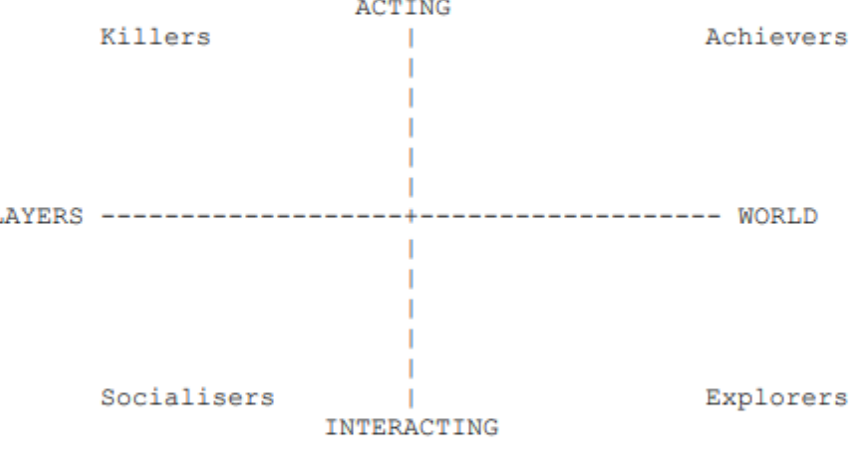
Figure 1. Four player types of Richard Bartle